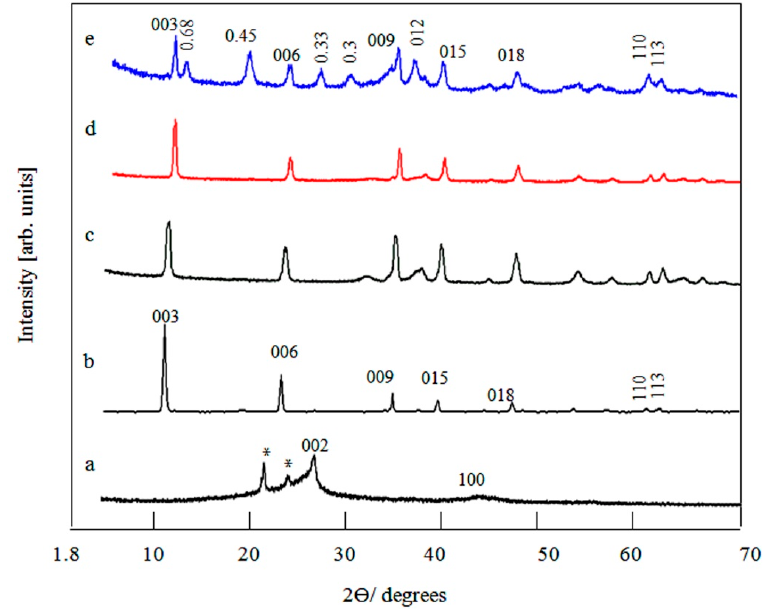
Figure 2. X-ray diffractions of ( a ) the prepared graphene, ( b ) Zn-Al LDH, ( c ) nanohybrid NH1, ( d